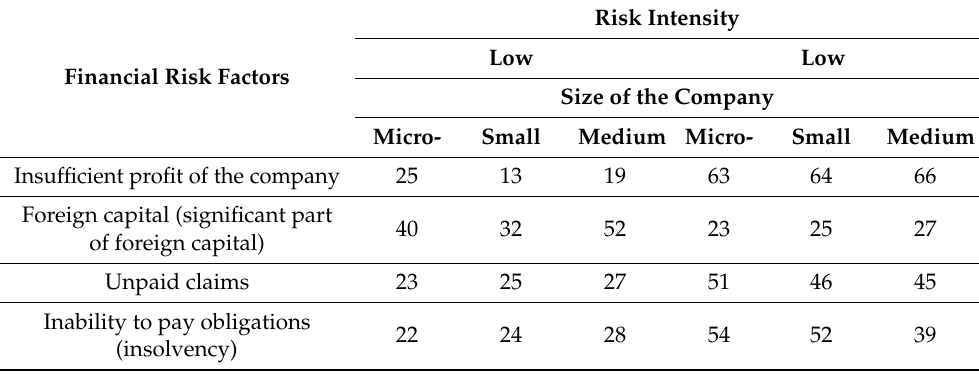
Table 4. Percentage of operational risk intensity broken down by the size of the company. Risk Intensity Low High Operational Risk Factors Size of the Company Micro- Small Medium Micro- Small Medium Incomplete use of production capacity